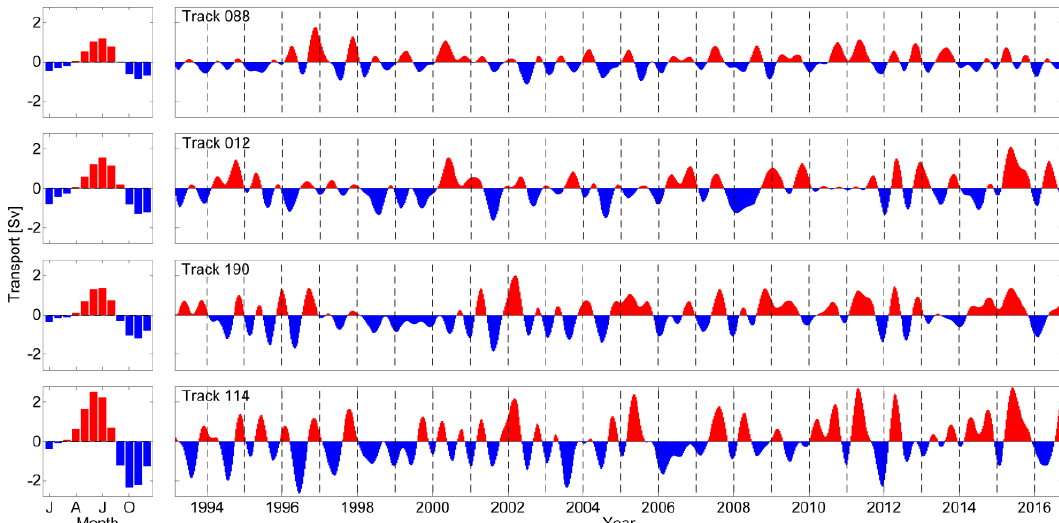
Figure 7. Seasonal cycles (left column) and interannual variabilities (right column) of along-shelf volume transport anomalies across the four ground tracks. Positive (red) or negative (blue) values represent northeastward or southwestward transports, respectively. Track numbers are shown in the upper left corner of right column panels.